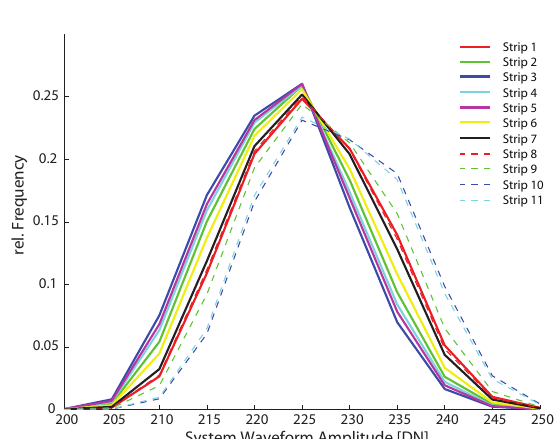
Figure 3: Histogram of the system waveform amplitudes ˆ S per flight strip in the 2004 campaign (bin size: 5 ).